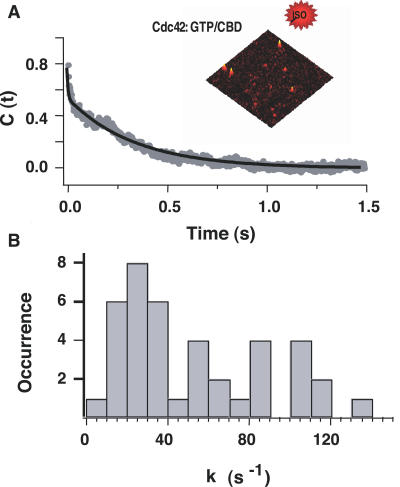
Single-Molecule Fluorescence and Spectroscopy Studies of Cdc42-CBD Protein–Protein Interaction Dynamics(A) Second-order auto-correlation function, C(t), calculated from a fluorescence intensity trajectory I(t) of a single Cdc42-CBD complex. Solid curve is a bi-exponential fit. (Inset) A single-molecule fluorescence raster-scanning image of GTP-loaded Cdc42 in complex with dye-labeled CBD biosensor.(B) The occurrence histogram of the single-complex conformational fluctuation rate for 60 individual protein complexes [19].